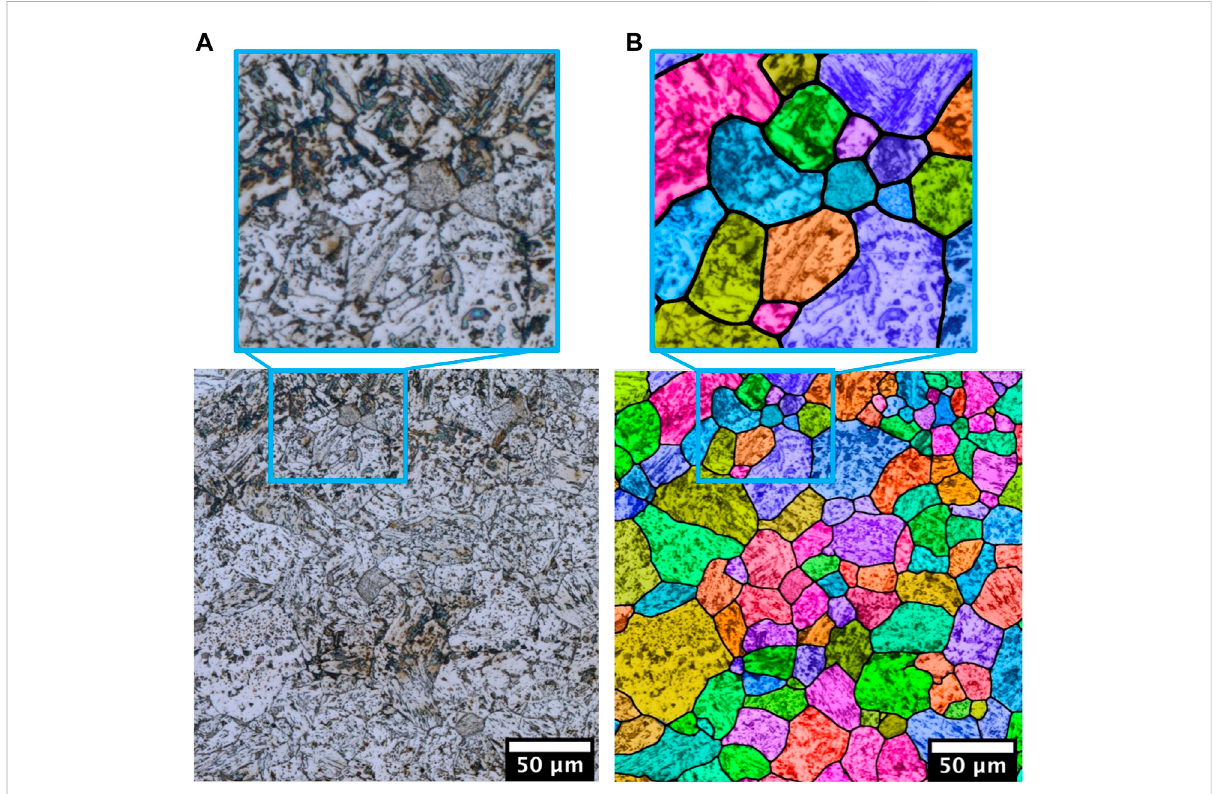
FIGURE 10 LOM micrograph of an unseen sample with etching artefacts (A) and the segmentation result after postprocessing (B) showing the color- labeled grains from the reconstruction.